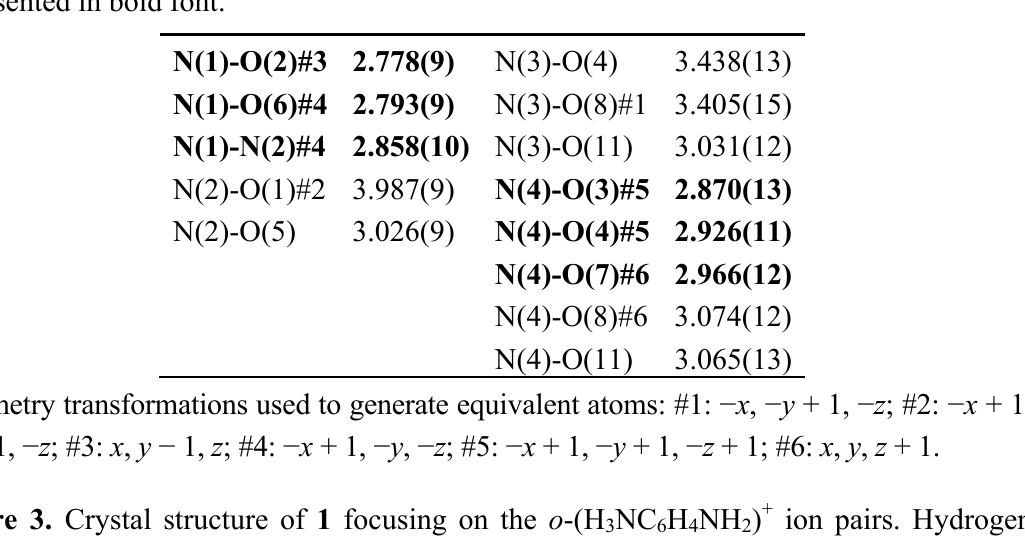
N(1)C H N(2)H ) + ions. (b) o -(H 3 6 4 2